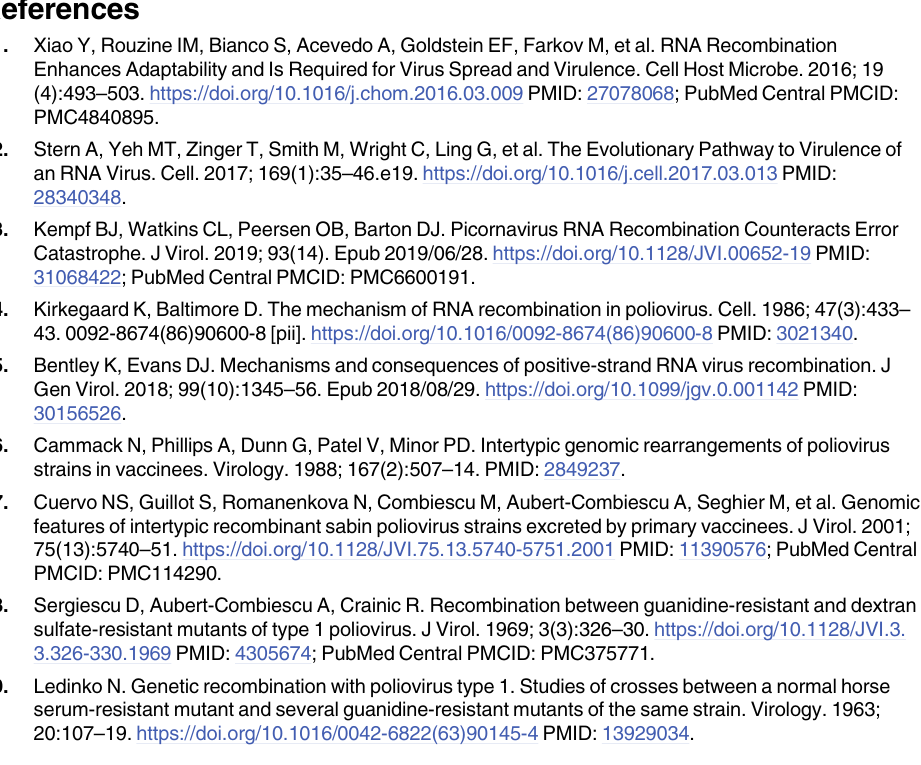
S3 Table. Barcoded #105B